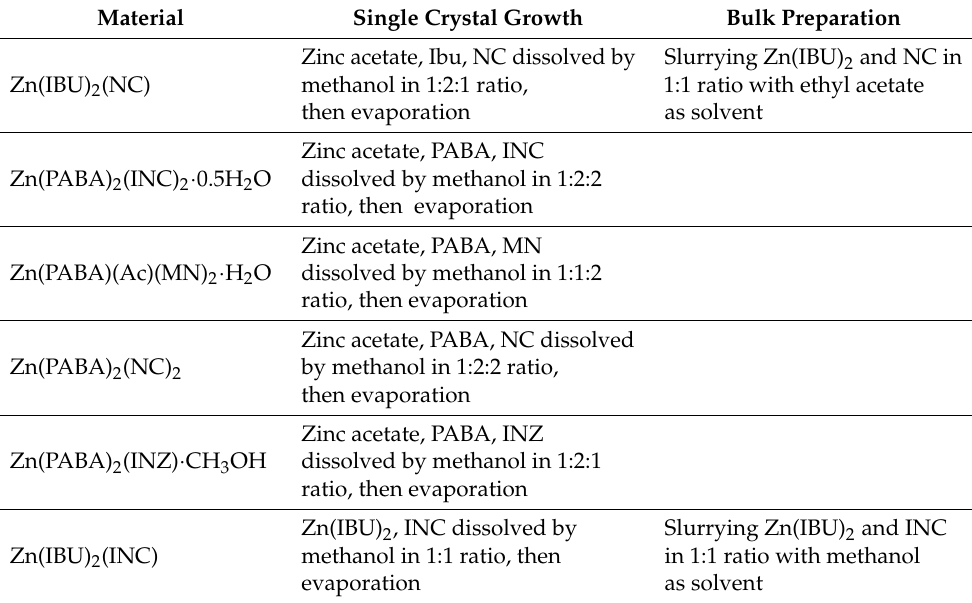
Table 2. Overview of the single crystal and Bulk Material preparation for the reported compounds.